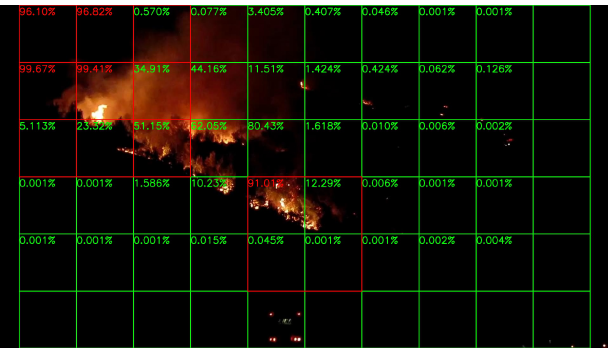
Figure 17. Night forest fire, 28 August 2011.